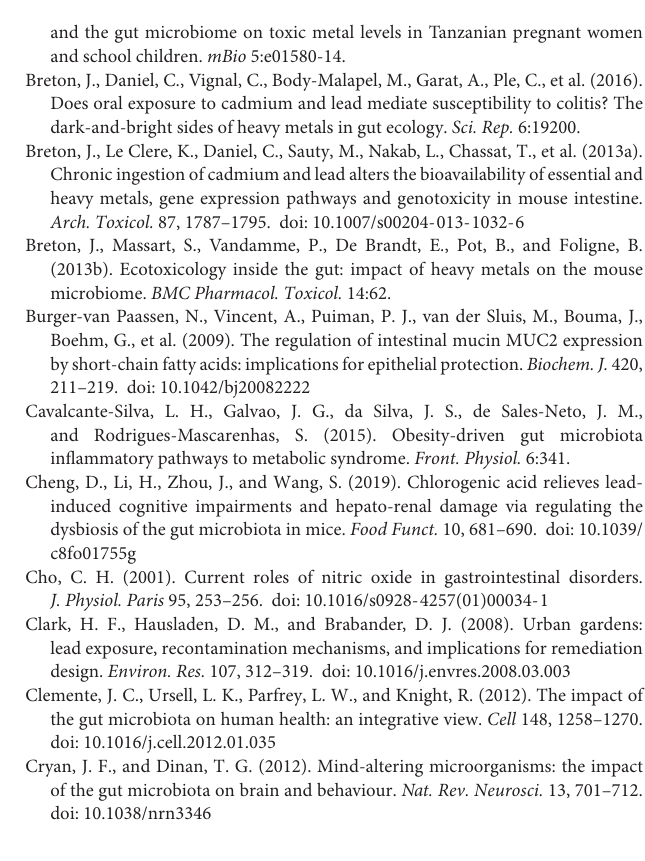
Supplementary Figure 1 | Pb toxicity on gut barrier. Pb can damage the gut barrier by inducing oxidative stress and decreasing tight junctions such as ZO-1, claudin-1, and occludin. Supplementary Figure 2 | Probiotics prevent Pb toxicity and improve gut health. Probiotics prevent Pb’s toxicity by uptaking and binding with it directly, or by producing SCFAs, increasing bile flow, upregulating the expression of tight junction, and reversing adverse reactions. Supplementary Figure 3 | Pb toxicity on ion transportation. At the time of lead exposure, lead enters inside the cell through Ca 2 + channel and binds with calmodulin in place of Ca 2 + , thereby altering the cellular function. Supplementary Figure 4 | α diversity of gut microbiome affected by